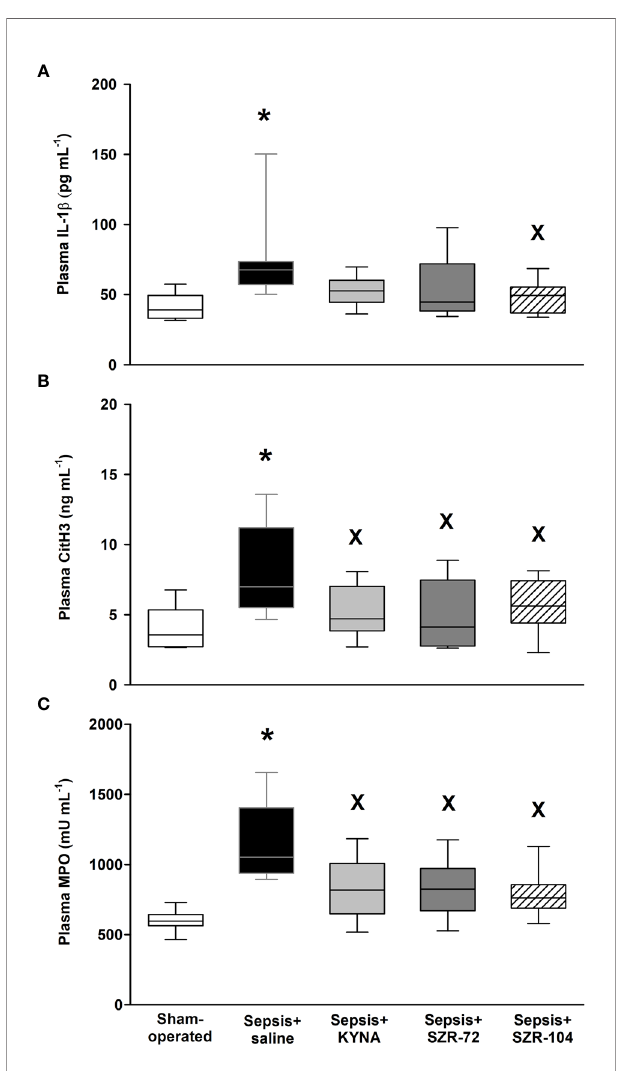
FIGURE 5 | Cerebellar (A) and hippocampal (B) levels of myeloperoxidase (MPO) in the sham-operated group and in the different sepsis groups treated with saline, KYNA, SZR-72 and SZR-104. The plots demonstrate the median (horizontal line in the box) and the 25 th (lower whisker) and 75 th (upper whisker) percentiles. Kruskal – Wallis test, Dunn ’ s post-hoc test; * P < 0.05 vs . sham-operated group; x P < 0.05 vs . sepsis+saline